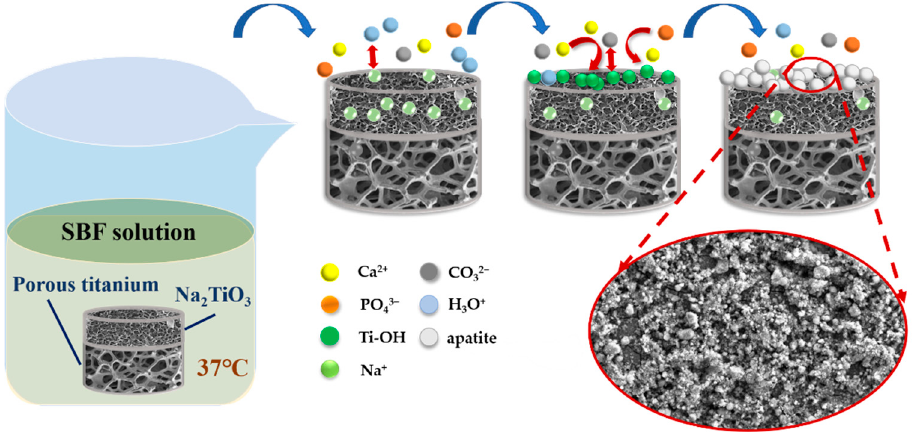
Figure 10. Schematic diagram of the mineralization mechanism of porous Ti treated with NaOH. Figure 11 outlines the cell proliferation assay for BMSCs with porous titanium treated with different concentrations of base. Mitochondria in living cells oxidize and reduce the dehydrogenase in cck-8 to form a water-soluble orange-yellow formazan dye, while dead cells do not have this function. The optical density (OD) of formazan was measured by a specific wavelength. The absorbance is proportional to the concentration of the substance, so the larger the OD value, the more the number of living cells. At the early stage of BMSC